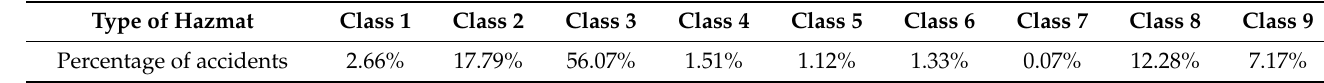
Table 3. Distribution of Accidents by type of